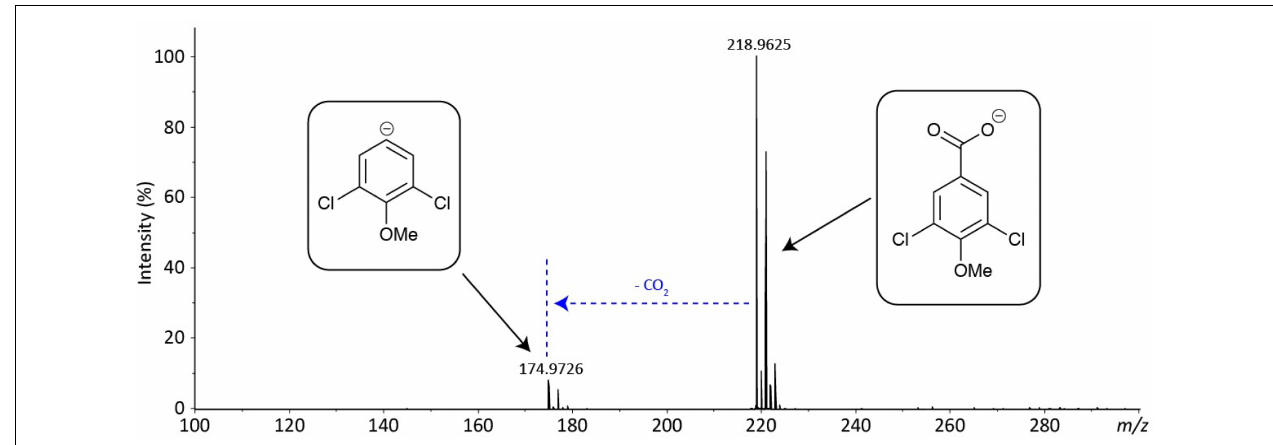
FIGURE 2 | Accurate-mass negative ion electrospray ionization (ESI) mass spectrum of fraction C—putative 3,5-dichloro-4-methoxy benzoic acid. The spectrum shows the [M-H] − at m / z 218.9625 (218.9621 for C 8 H 5 O 3 Cl 2 − ) and fragmentation resulting from decarboxylation at m / z 174.9726 (174.9723 for C 7 H 5 OCl 2 − ).